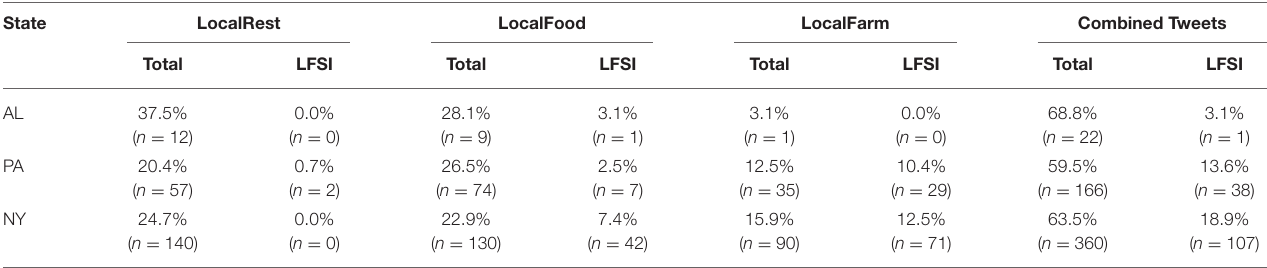
TABLE 3 | Results of thematic analysis of local restaurant/food/farm tweets out of all 2020 local tweets within the state to identify tweets that reference local food system infrastructure (LFSI).